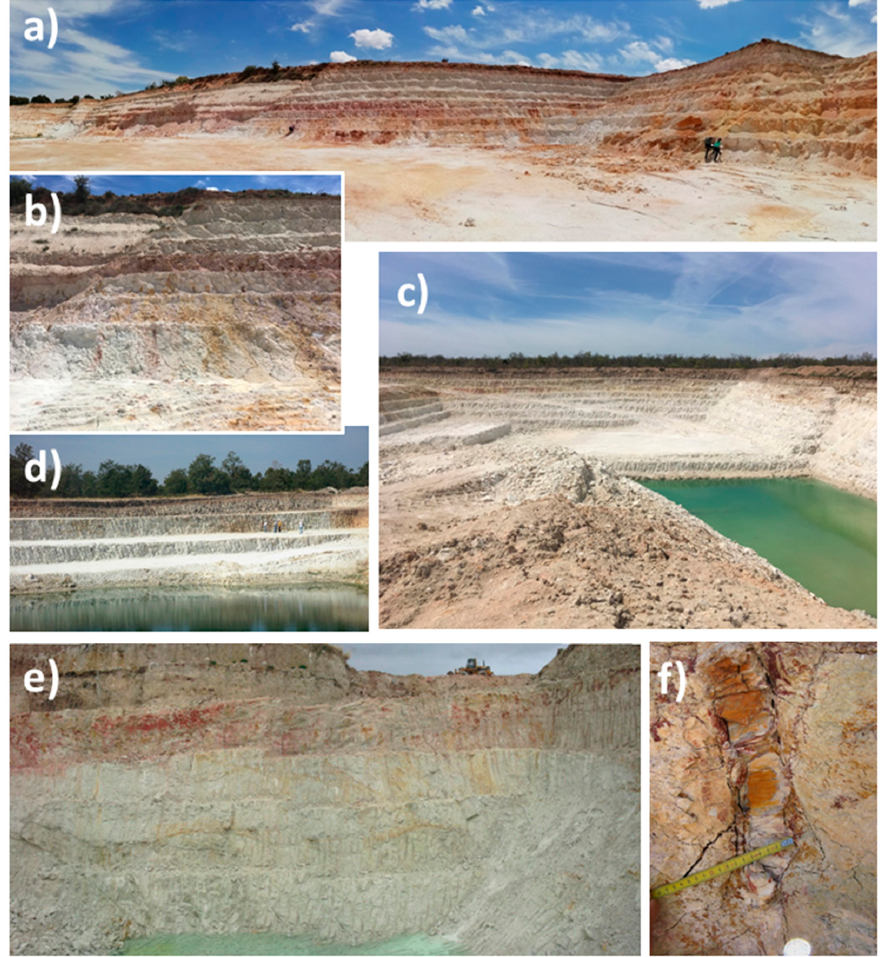
Figure 6. Representative images from the Tamame de Sayago quarries: ( a , b ) the Roderica quarry and ( c , d ) the Carboneras quarry. ( e ) East front of the Navalacruz quarry; ( f ) detailed image of a pure smectite vein in